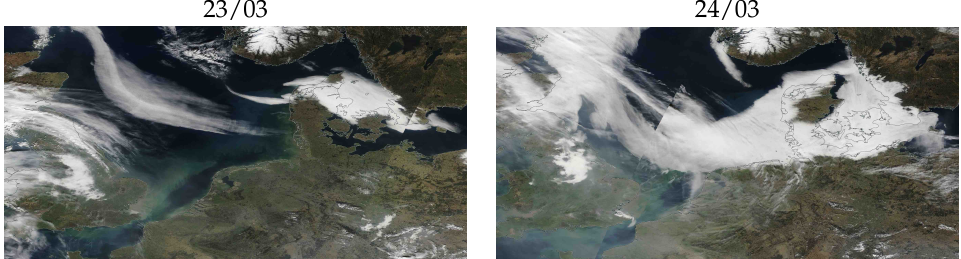
Figure 6. North Sea. Terra satellite MODIS images on 23 and 24 March 2012 at approximately 11 UTC (NASA